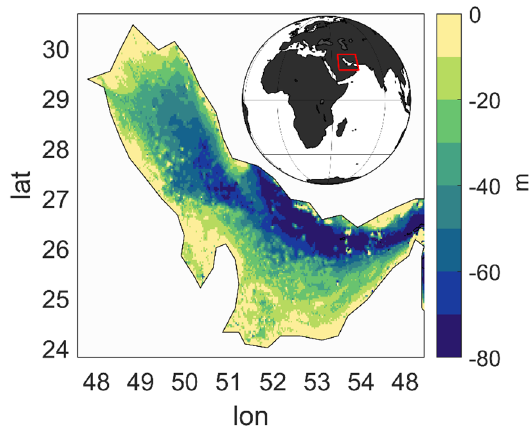
Figure 1. Arabian Gulf (AG) location and bathymetry in (m).